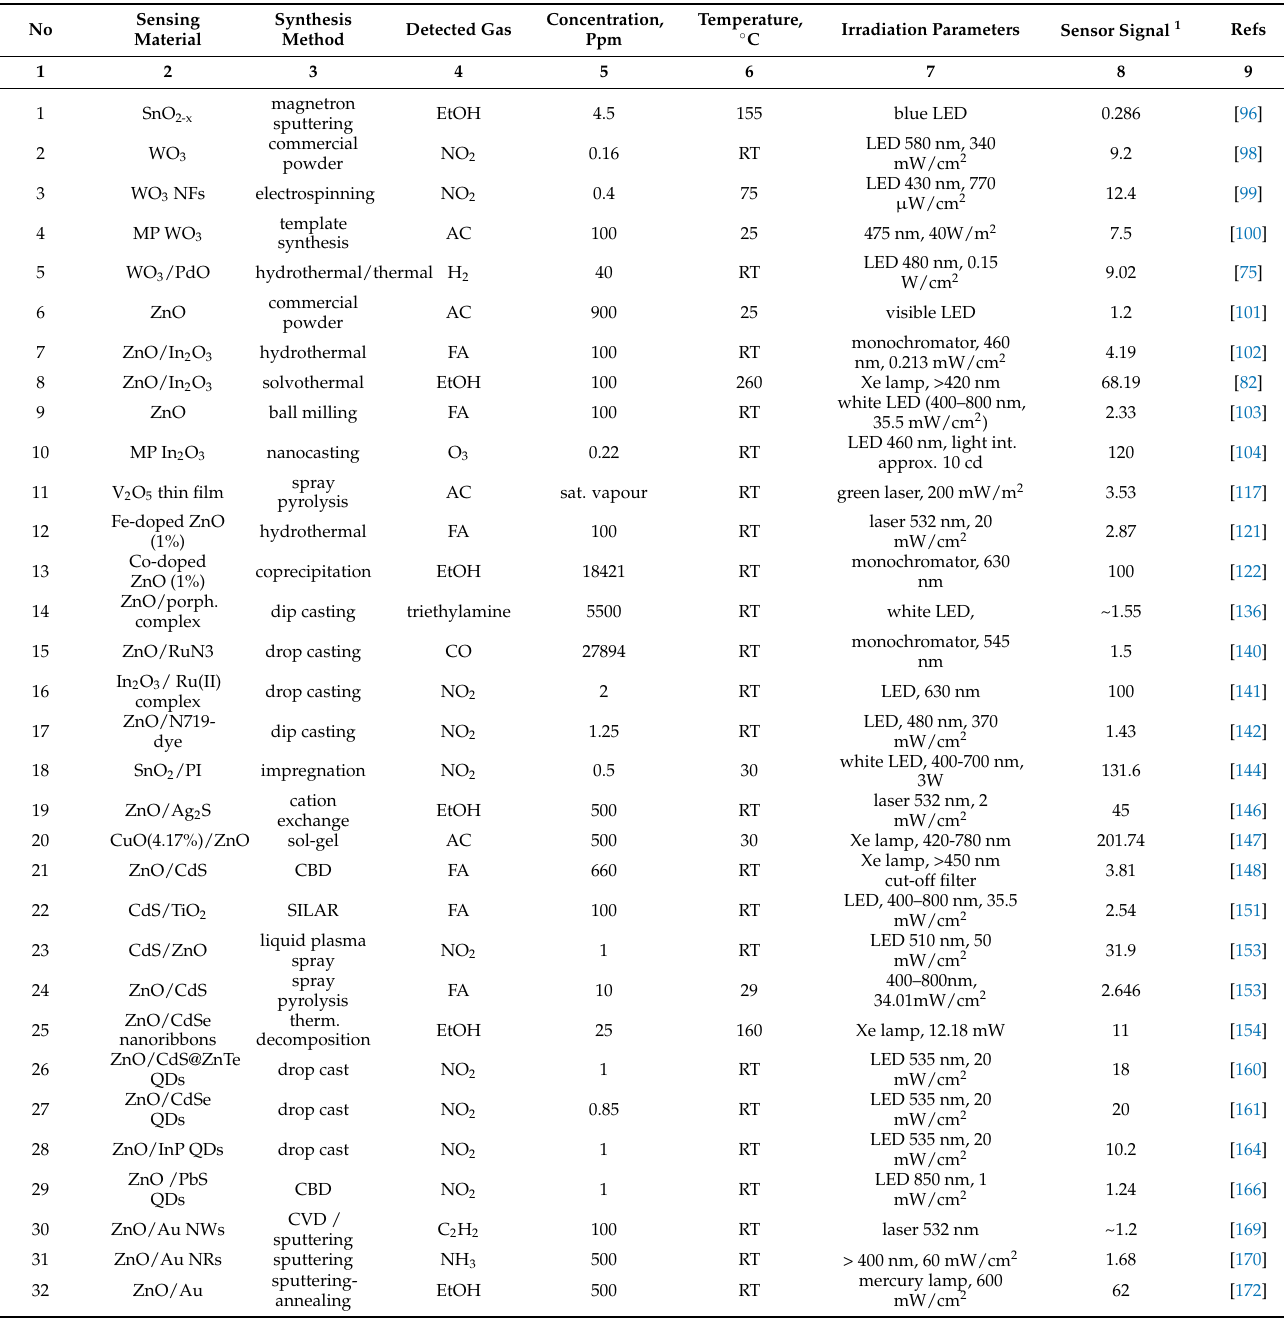
Table 3. Sensor signal of sensitized wide-gap oxides in the detection of various gases when activated by visible light. CBD—chemical bath deposition; RT—room temperature; FA—formaldehyde, EtOH—ethanol, AC- acetone; NRs—nanorods, NWs—nanowires,